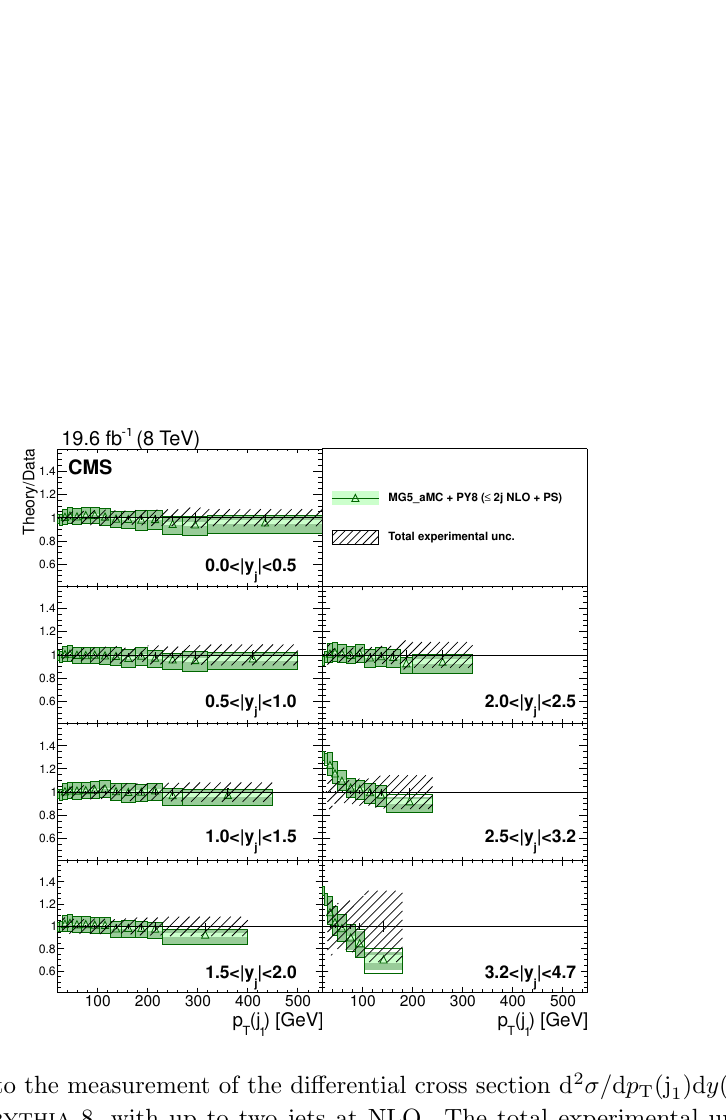
)d y (j ) obtained 1 1